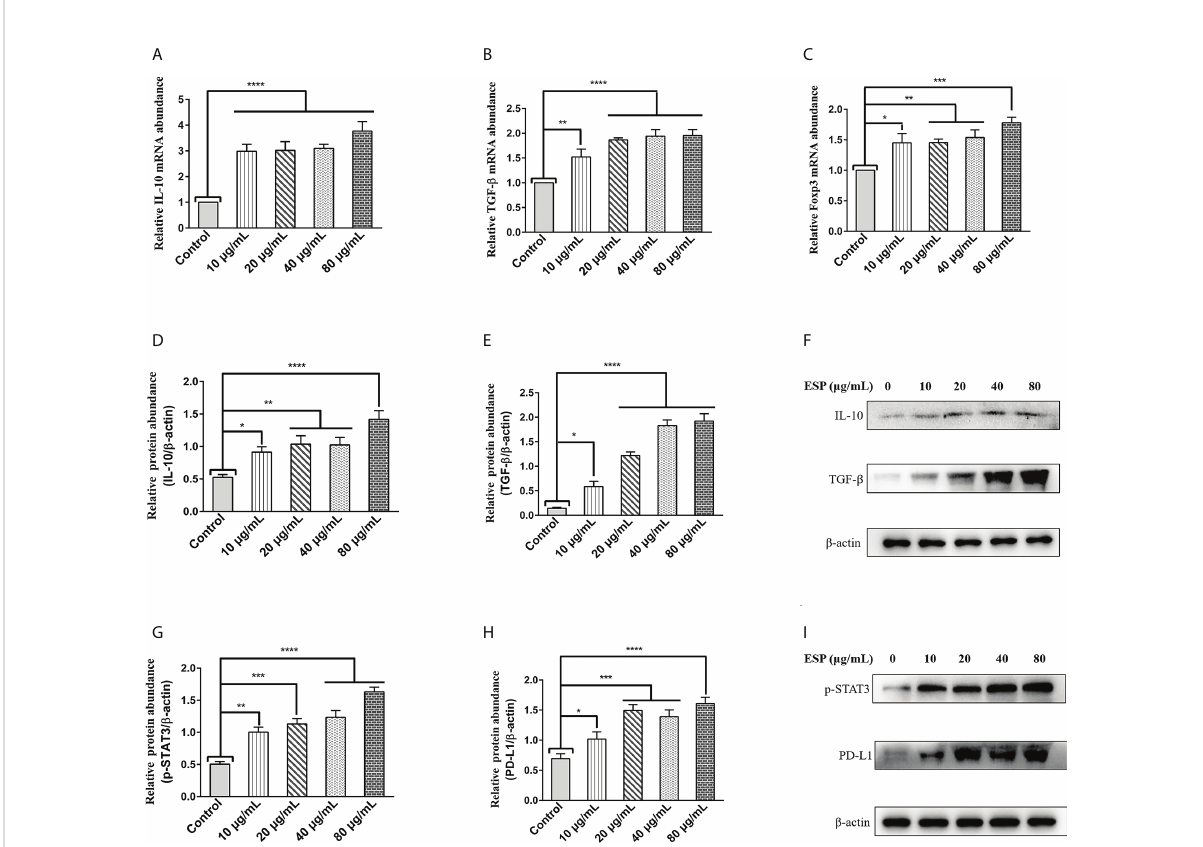
FIGURE 2 HcESPs promoted the expression of Treg cell markers and activated the STAT3/PD-L1 pathway. Cells were incubated with different concentrations (10, 20, 40, 80 m g/mL) of HcESPs, and an equal volume of RPMI 1640 medium (control) at 37°C and 5% CO 2 for 24 h. (A – C) : The transcript levels of IL-10, TGF- b , and Foxp3 were detected by qPCR assays; (D – F) : Detection of relative protein expression levels of IL-10 and TGF- b by Western blot; (G – I) : Detection of relative protein expression levels of p-STAT3, PD-L1 by Western blot; Data are presented as the mean±SEM from three independent experiments. * P <0.05, ** P <0.01, *** P <0.001, **** P <0.0001 vs the control